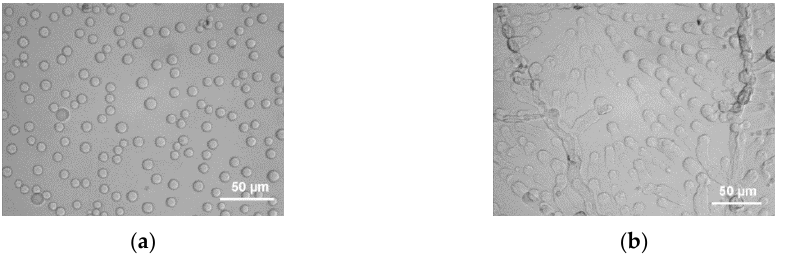
Figure 6. optical micrographs obtained on BHPB-10/ trans -decahydronaphthalene systems X = 0.05 g/cm 3 ( a ) within the miscibility gap; ( b ) just after crossing the monotectic line [30].